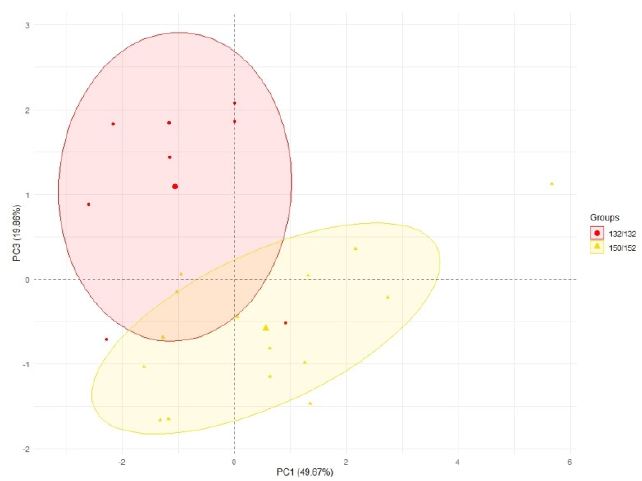
Figure 2. PCA for the SW1808 marker in Polish Large White sows: A scatterplot of PC1 against PC3, with the indication of the genotype. PC1 was positively correlated with the number and the percentage of stillborn piglets, and negatively correlated with the percentage of live-born piglets. PC3 was positively correlated with the number and the percentage of weaned piglets. The axes represent loadings onto components 1 and 3, while the two ellipses represent the two genotypes. Table 9. Summary statistics of the traits related to litter size in the Polish Landrace sows.